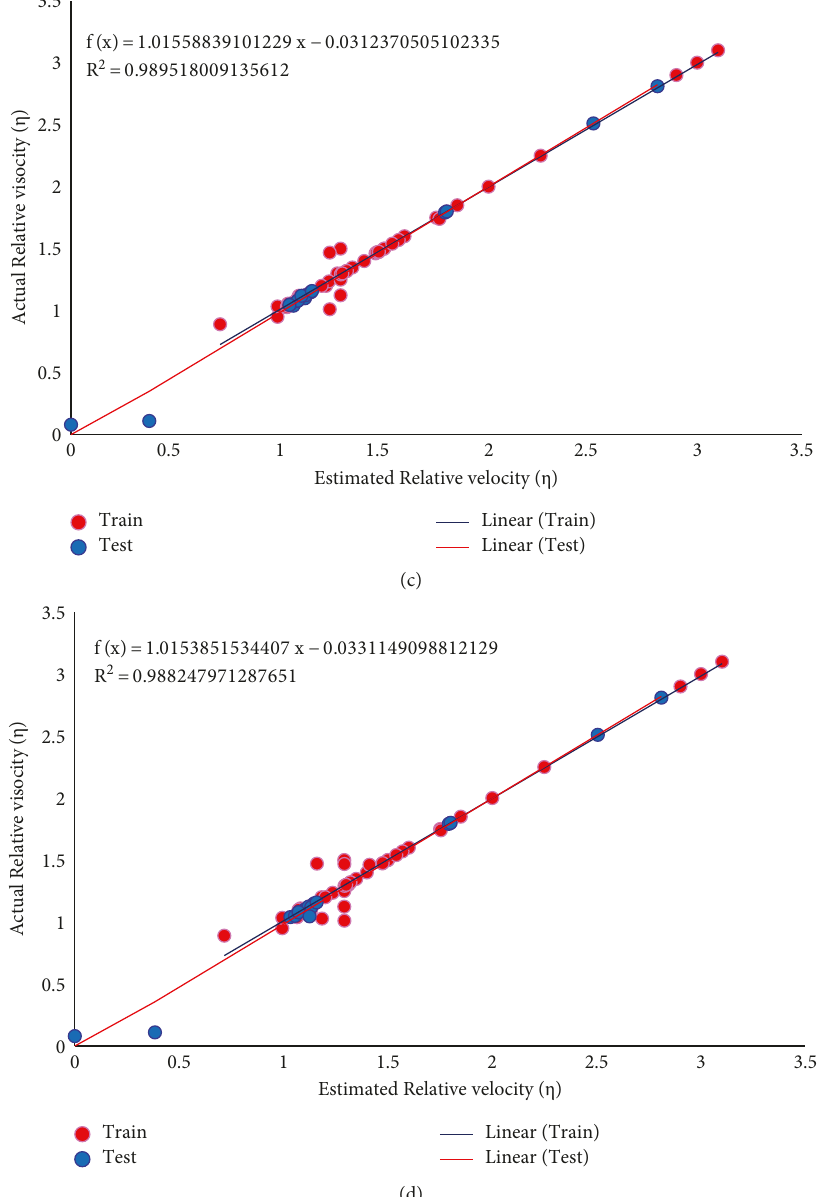
Figure 2: Linear regression on the models proposed in this research: (a) Matern, (b) exponential, (c) squared exponential, and (d) rational